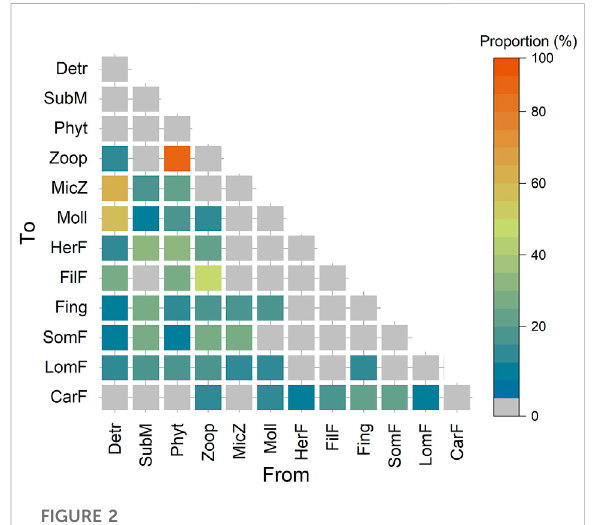
FIGURE 2 The relative contributions of the food sources to consumers in 2019. Data for the other four representative historical years are presented in Supplementary Figure S1. Abbreviations of trophic groups: CarF, carnivorous fi sh; Detr, detritus; FilF, fi lter- feeding fi sh; Fing, fi ngerlings; HerF, herbivorous fi sh; LomF, large omnivorous fi sh; MicZ, meiofauna; Moll, mollusks; Phyt, phytoplankton; SomF, small omnivorous fi sh; SubM, submerged macrophytes; Zoop, zooplankton.